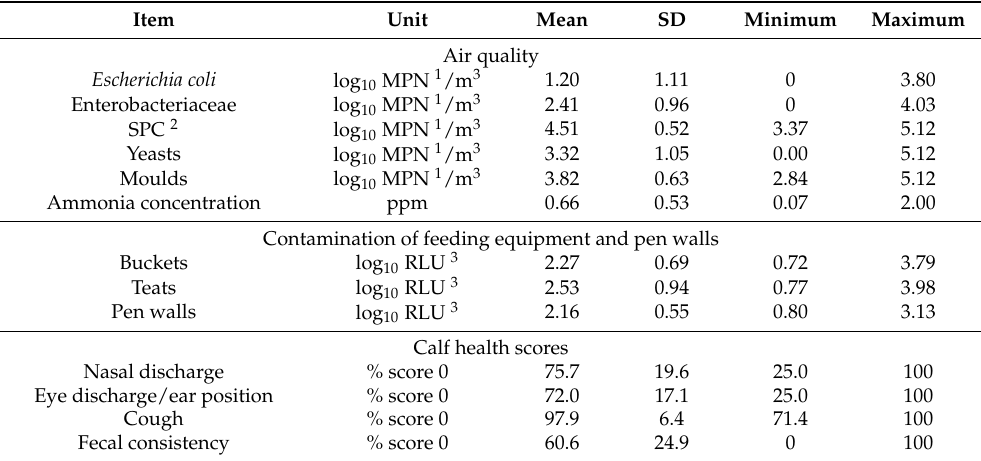
Table 2. Air quality, contamination of pen walls and feeding equipment, and calf health scores ( n = 25).